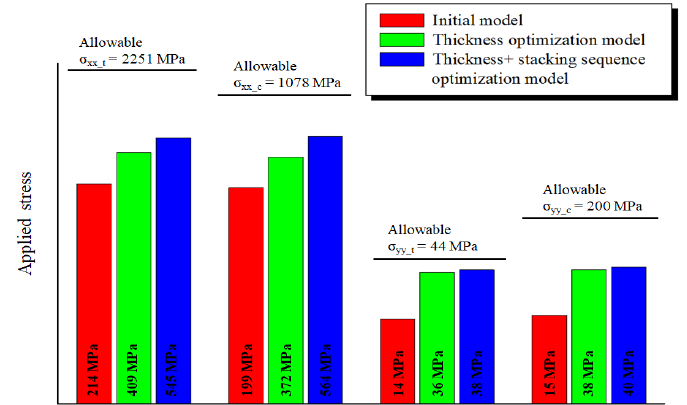
Figure 15. Comparison of each model’s applied stress results.